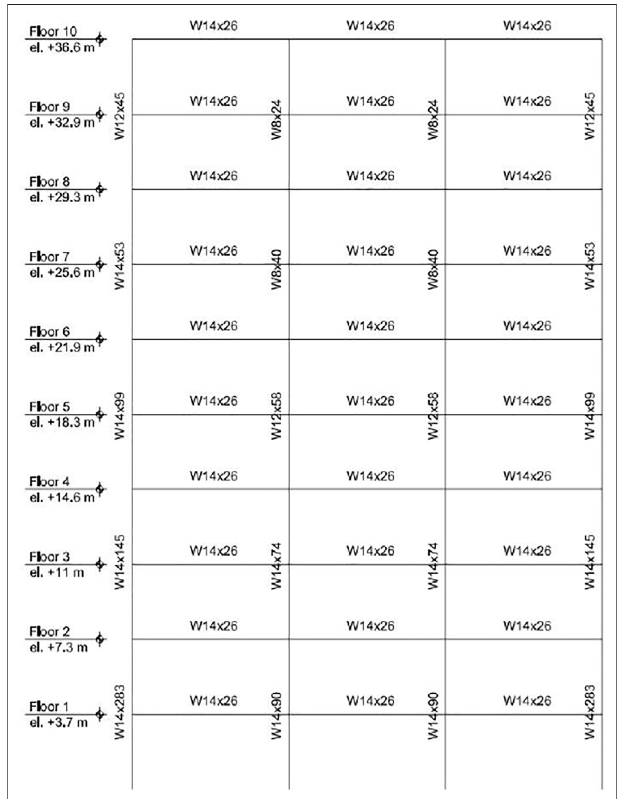
FIGURE 1 | Elevation of gravity framing members on grid lines B, C, D, and